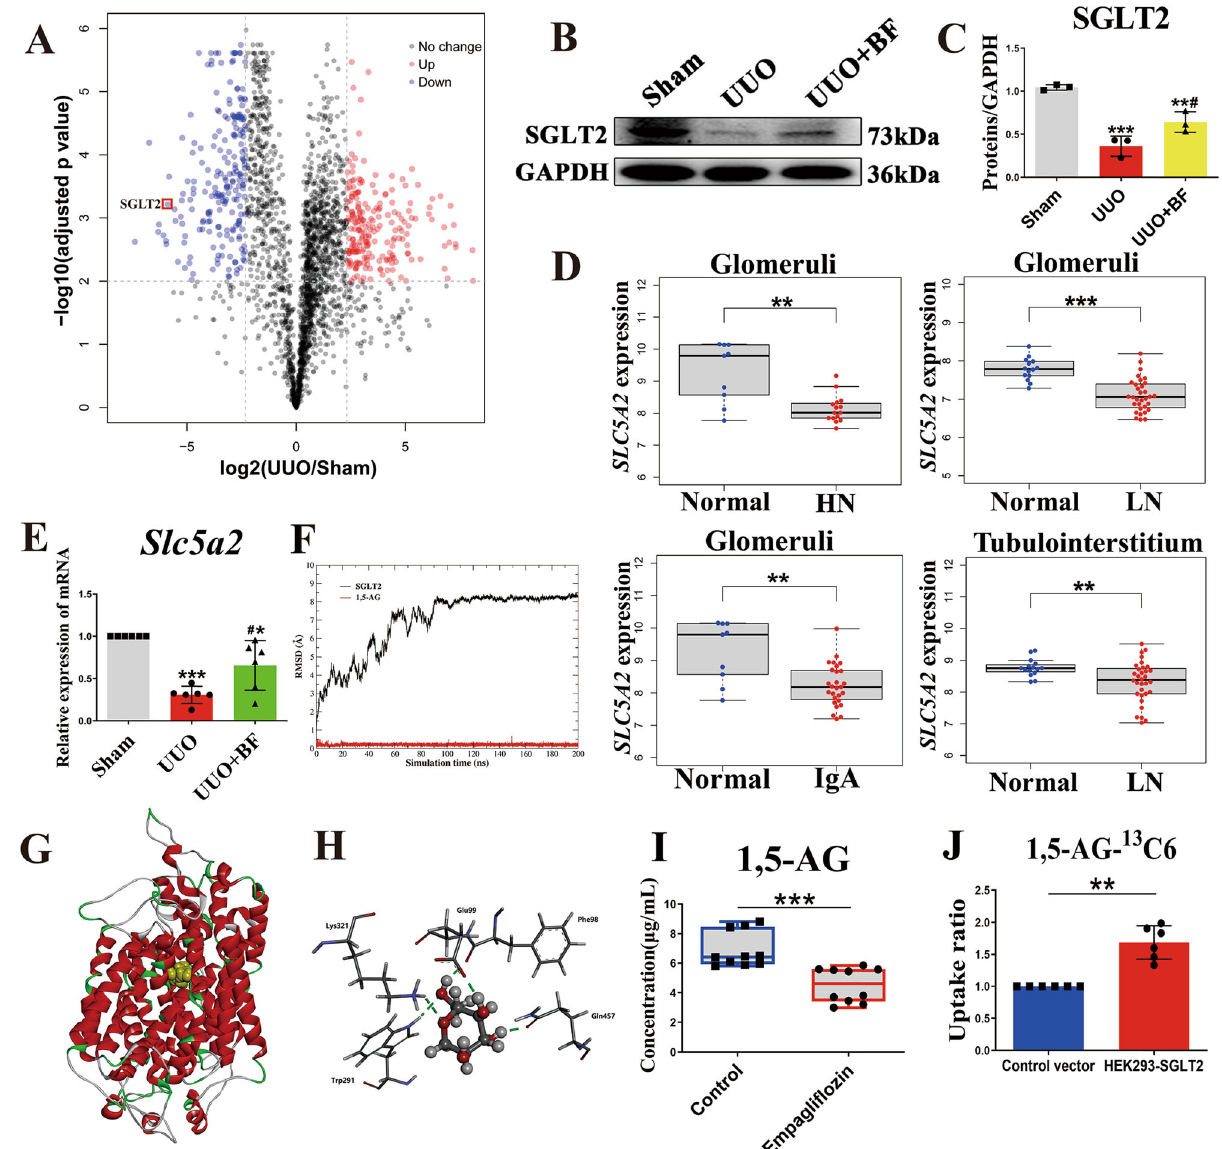
Fig. 5 | SGLT2 as a 1,5-AG transporter in the kidney. A Differentially expressed proteins of kidney tissues in UUO vs Sham are highlighted with volcano plot. The blue dots indicate the downregulated proteins, and the red dots indicate the upregulated proteins. B Western blot shows SGLT2 protein expression in kidneys from sham, UUO and UUO+BF ( B. fragilis ). C Quantitative analysis of panel B ( n =3). *** p =0.0004 forSGLT2: Sham vs. UUO,** p =0.0072 for SGLT2: Shamvs. UUO+BF, # p =0.0394 for SGLT2: UUO vs. UUO+BF. D mRNA level of Slc5a2 was investigated in the GEO database using 153 subjects. Log-transformed SLC5A2 mRNA level was compared not only between glomeruli from healthy people (Normal) ( n =14) and lupus nephritic patients (LN) ( n =32), but also between tubulointerstitiumfromhealthypeople( n =15)andlupusnephriticpatients( n =32) using Mann-Whitney U test; Log-transformed SLC5A2 mRNA level was compared not only between glomeruli from healthy people ( n =9) and hypertensive nephropathic patients (HN) ( n =9), but also between glomeruli from healthy peo- ple ( n =15) and IgA nephropathic patients ( n =27) using Mann-Whitney U test. ** p =0.0083 for Glomeruli HN; *** p <0.0001 for Glomeruli LN; ** p =0.0096 for Glomeruli IgA; ** p = 0.0091 for Tubulointerstitium LN. E mRNA level of SLC5A2